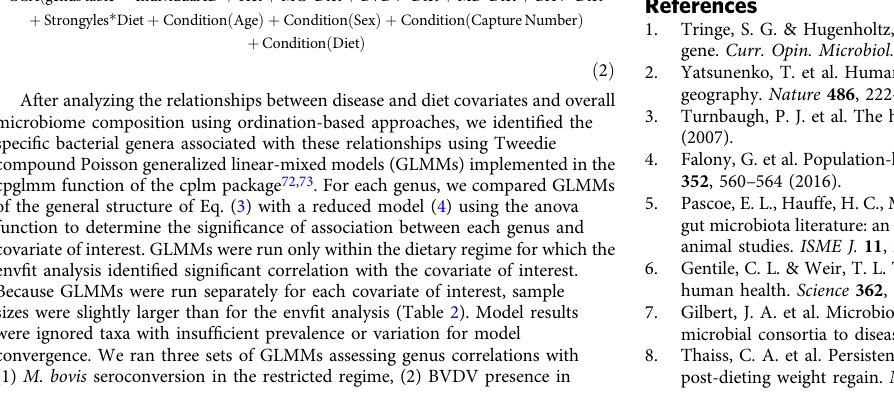
Eachindividualwassampledonlyonceateachcaptureperiod.Allsampleswereusedforalphaandbetadiversityanalysisandenv fi tanalysis.Onlysamplesthatwereaccompaniedbycompletecovariate datasets were included in the CCA. Normalized difference vegetation index (NDVI) was summarized as mean NDVI values for the MODIS pixels overlapping the boma during the time period most closely preceding the capture. Dietary regime was classi fi ed as “ restricted ” if NDVI was <0.5 and little or no supplementary feed was provided, with the exception of December 2016, which